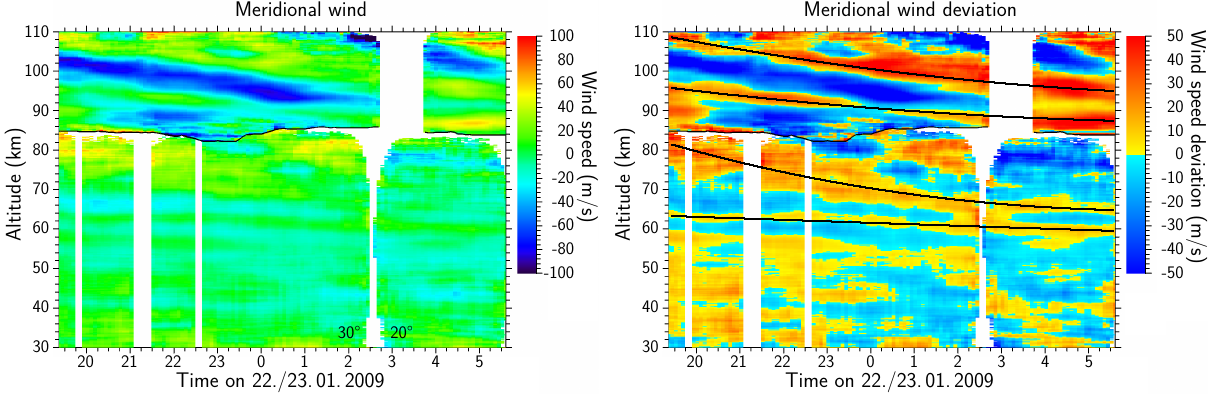
Fig. 12. Time-height section of absolute meridional wind speed (left panel) and its deviation from the mean wind speed profile (right) on 22/23 January measured by RMR and Na resonance lidar with the NWT. The elevation angle was changed at 02:30UT from 30 ◦ to 20 ◦ off-zenith. Black lines in the right panel highlight maxima of wind deviation showing a wavelike structure with varying amplitudes, vertical wavelengths, and slope of the